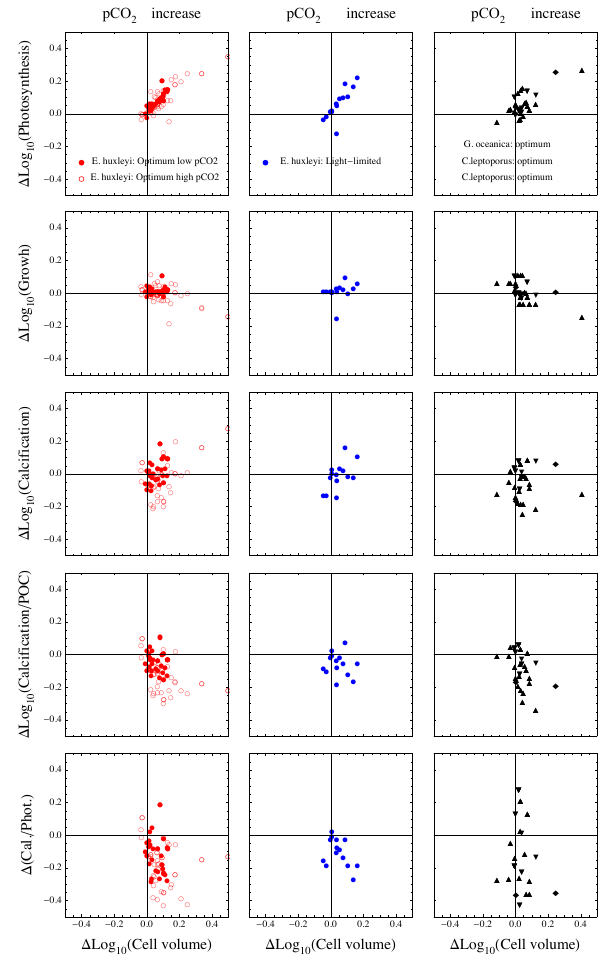
Figure 5. Changes in cell size and metabolic rates of E. huxleyi cells (first two columns) and other coccolithophore species (last column) subject to an increase in p CO 2 . Note: for E. huxleyi symbols denote optimum low- p CO 2 conditions (red circles), optimum high- p CO 2 conditions (red dots), light-limited conditions (blue dots); for the other coccolithophore species symbols denote the species and all conditions are optimum, without distinction of p CO 2 range (see Table 2 for definition of growth conditions).